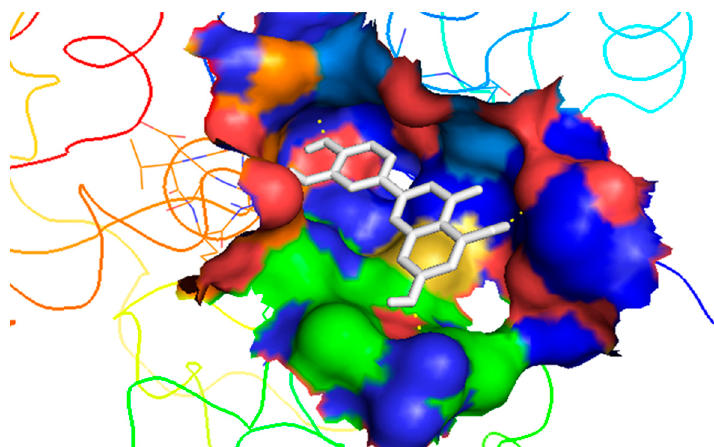
Figure 4. ZINC000018185774 firmly docked into metal binding site 2 of ideR. The binding site is shown as a solid surface whilst the ligand is shown in white stick model. The image was generated with PyMOL. Table 3. Table of Top 20 hits and five potent inhibitors with their binding energies and interacting metal binding site-2 residues. Residues were determined using the processed_VinaResult.py script in the Autodock tools package.